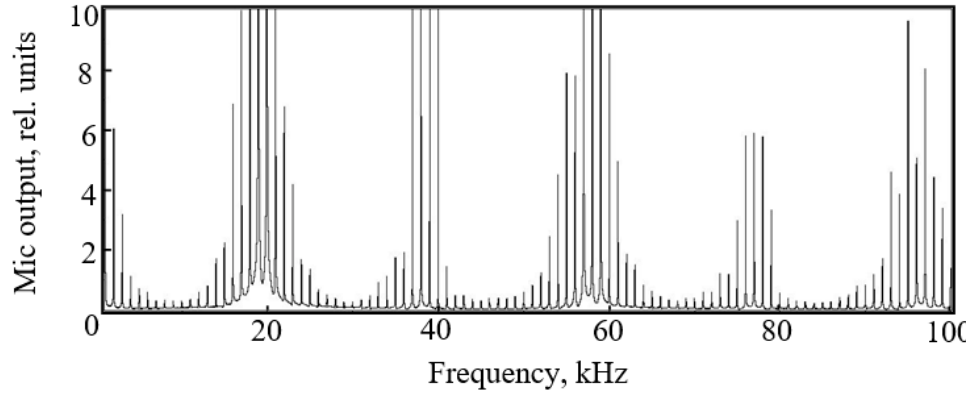
Figure 13. Mixed-frequency resonant AE spectrum for 19 kHz and 20 kHz primary wave interactions.